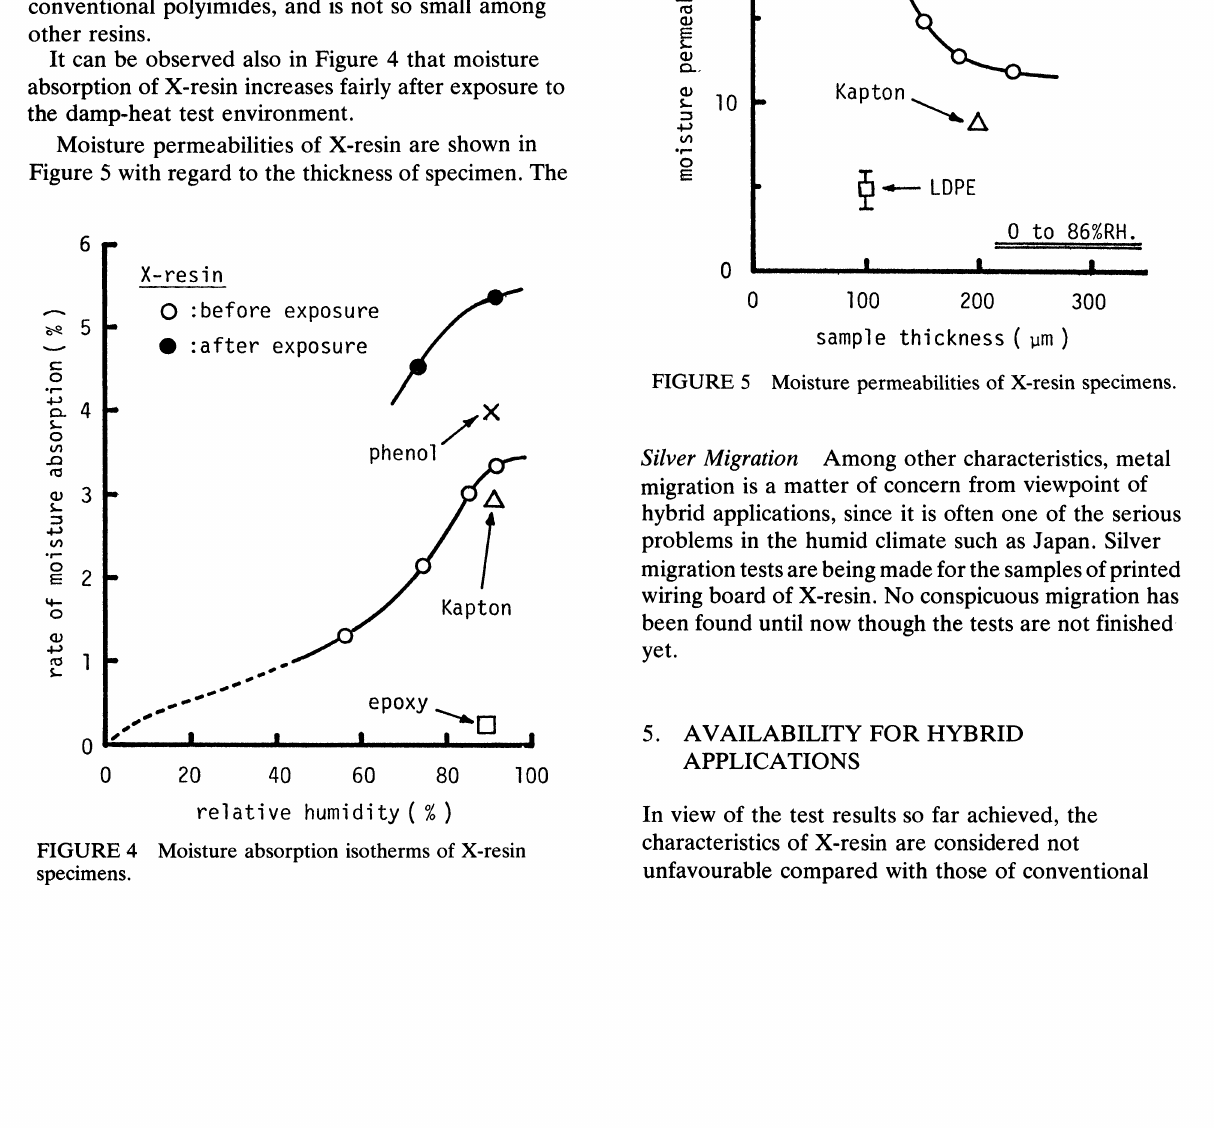
FIGURE 5 Moisture permeabilities of X-resin